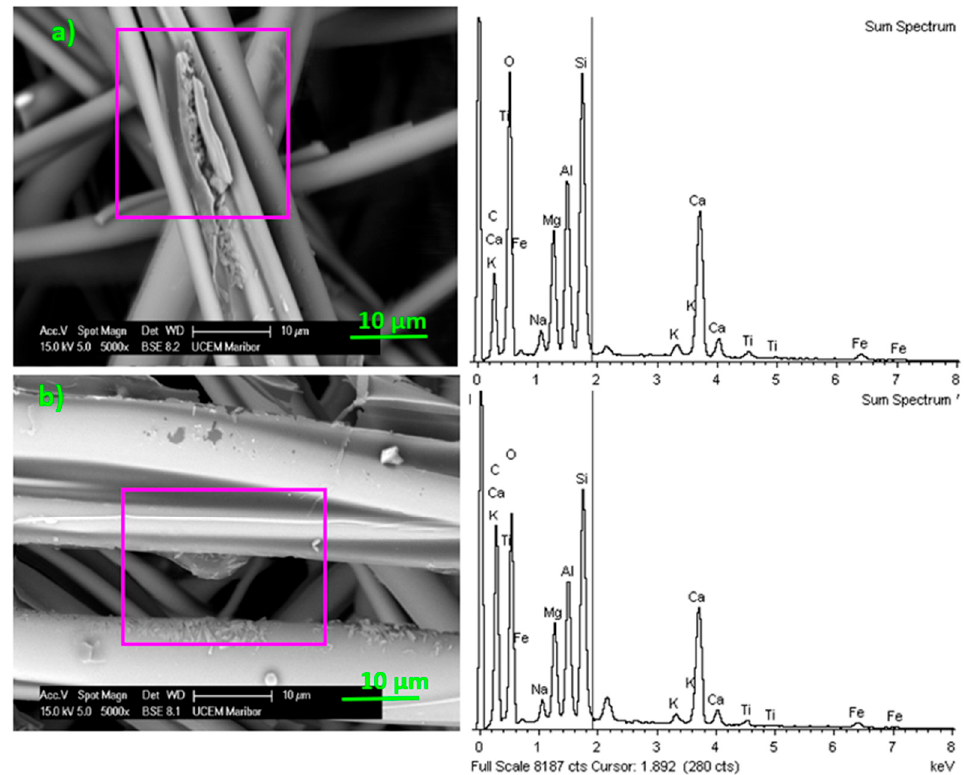
Figure 8. SEM-EDX spectra of the surface of mineral wool fabricated from basalt fibers with two characteristic defects: ( a ) cracks and ( b ) bulges.